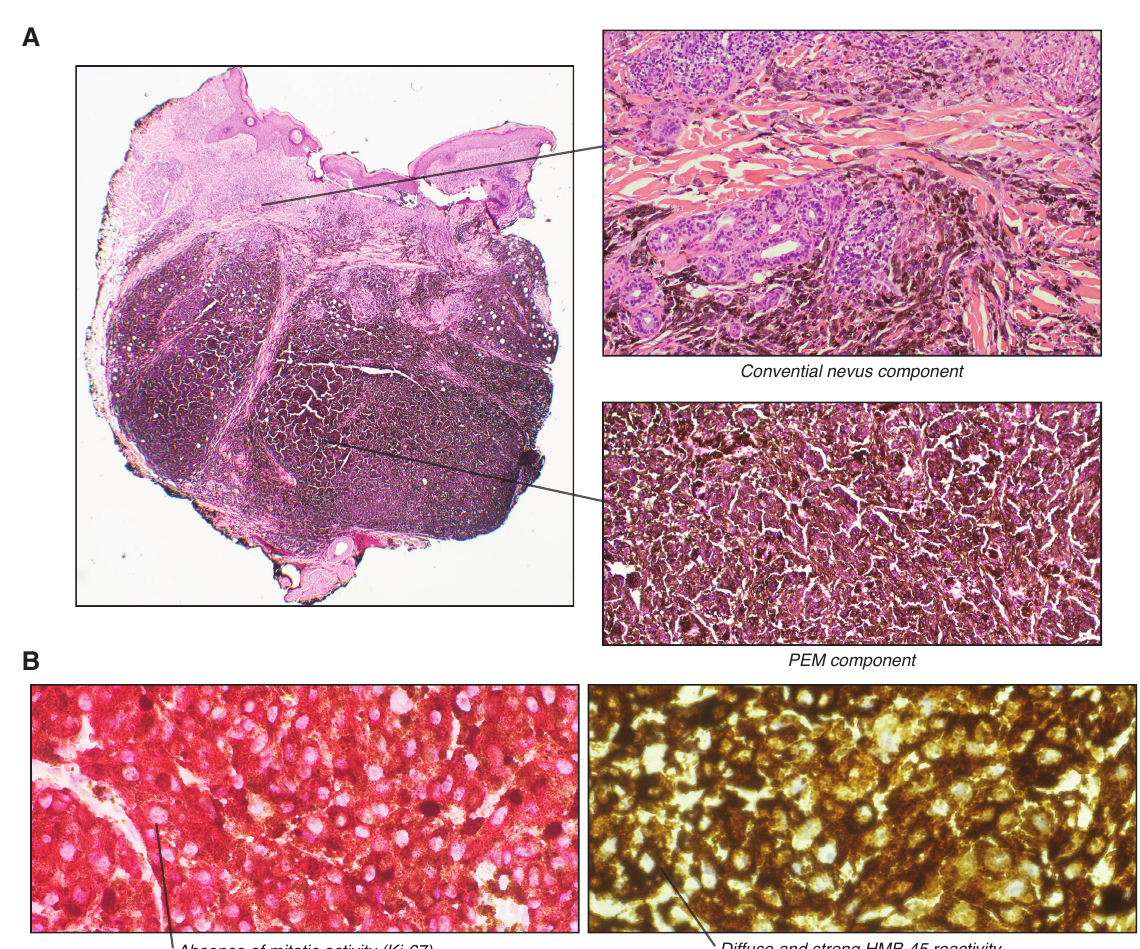
Figure 2. Microscopic examination. ( A ). (left) Low-power view of the tumor, presenting as a 4 mm nodule located in the deep dermis and extending into the subcutaneous fat. (top right) Heavily pigmented melanocytes have epithelioid and spindled appearance. (bottom right) Combined blue nevus-like component. ( B ). (left) Ki-67 immunohistochemistry showing absence of mitotic activity. (right) HMB-45 immunohistochemistry shows diffuse and strong reactivity in tumor